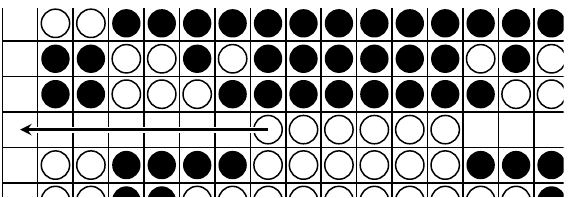
Figure 82. W-magnet, abbrev.